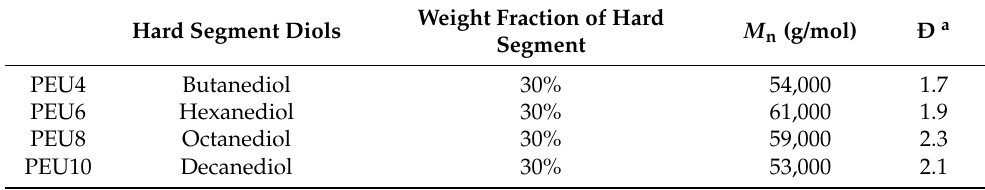
Table 1. Compositions and molecular weights of PEU. Hard Segment Diols